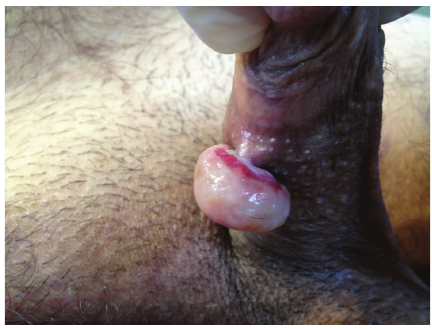
Figure 2: Pyogenic granuloma of the penis, which had a narrow